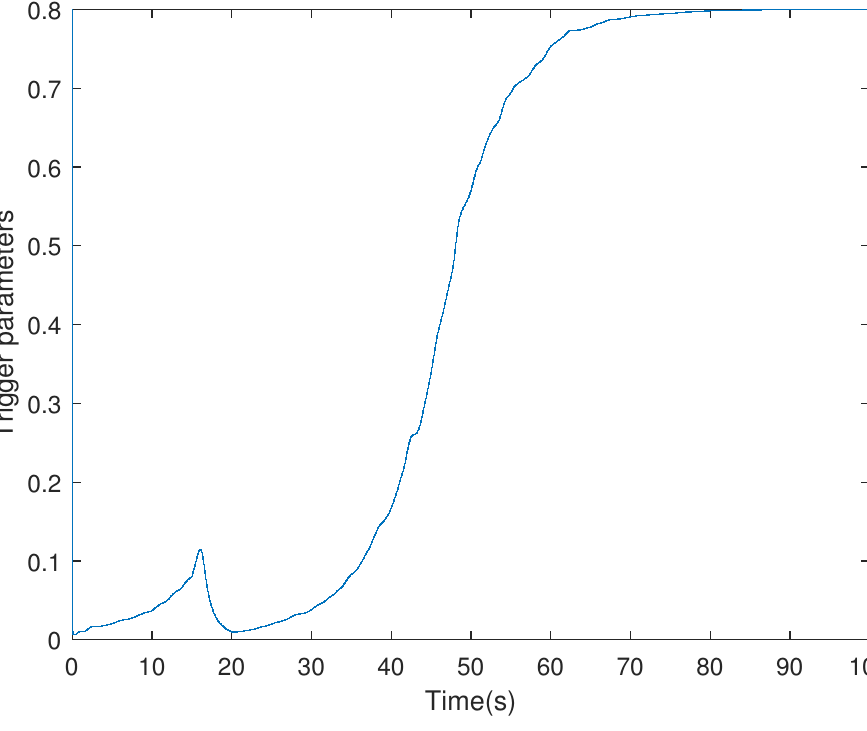
Figure 4. The threshold σ ( t ) of the LFC system with the adaptive ETS in Case